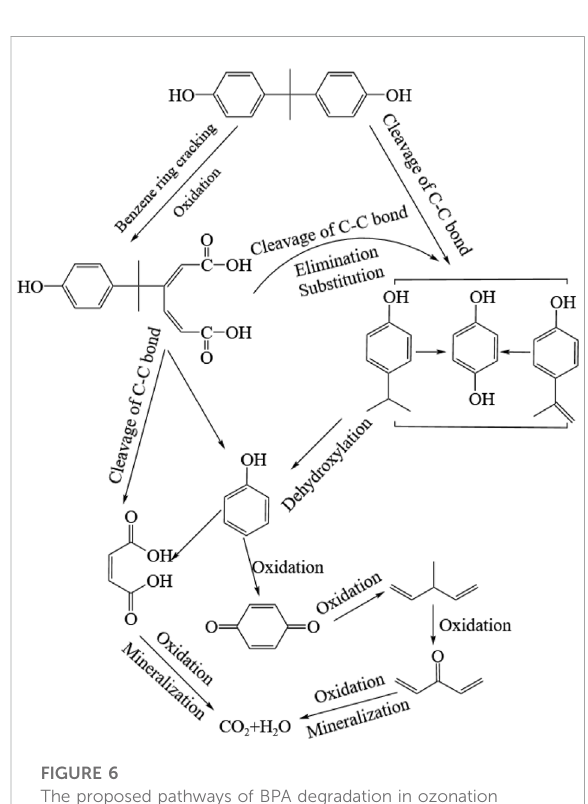
FIGURE 6 The proposed pathways of BPA degradation in ozonation process.